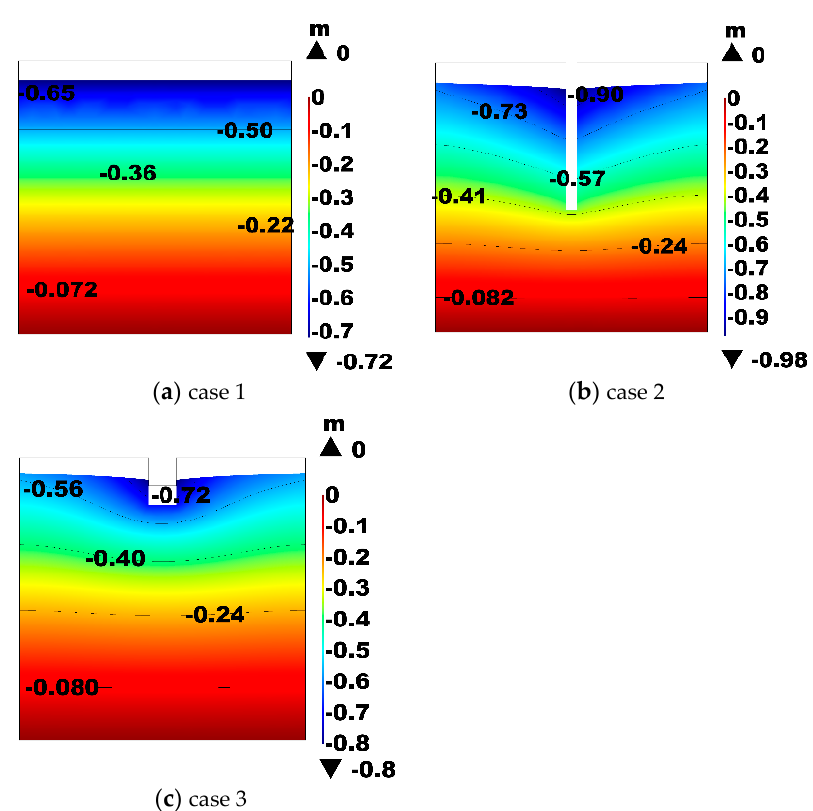
Figure 11. Validation of compression strain calculation results.